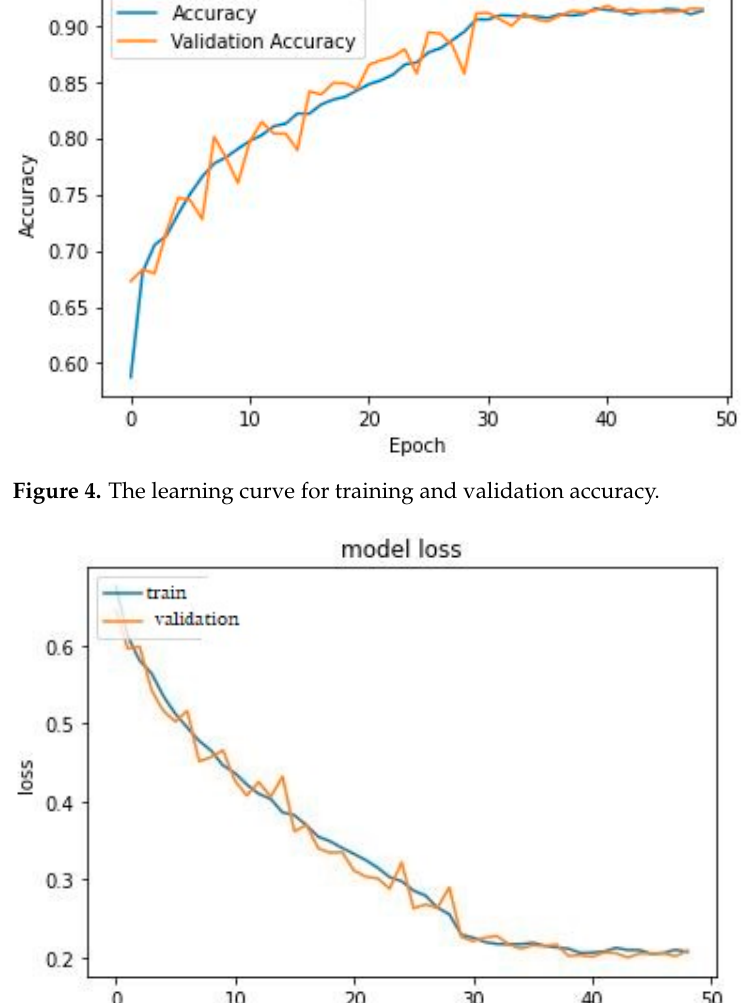
Figure 5. The learning curve for training and validation loss.